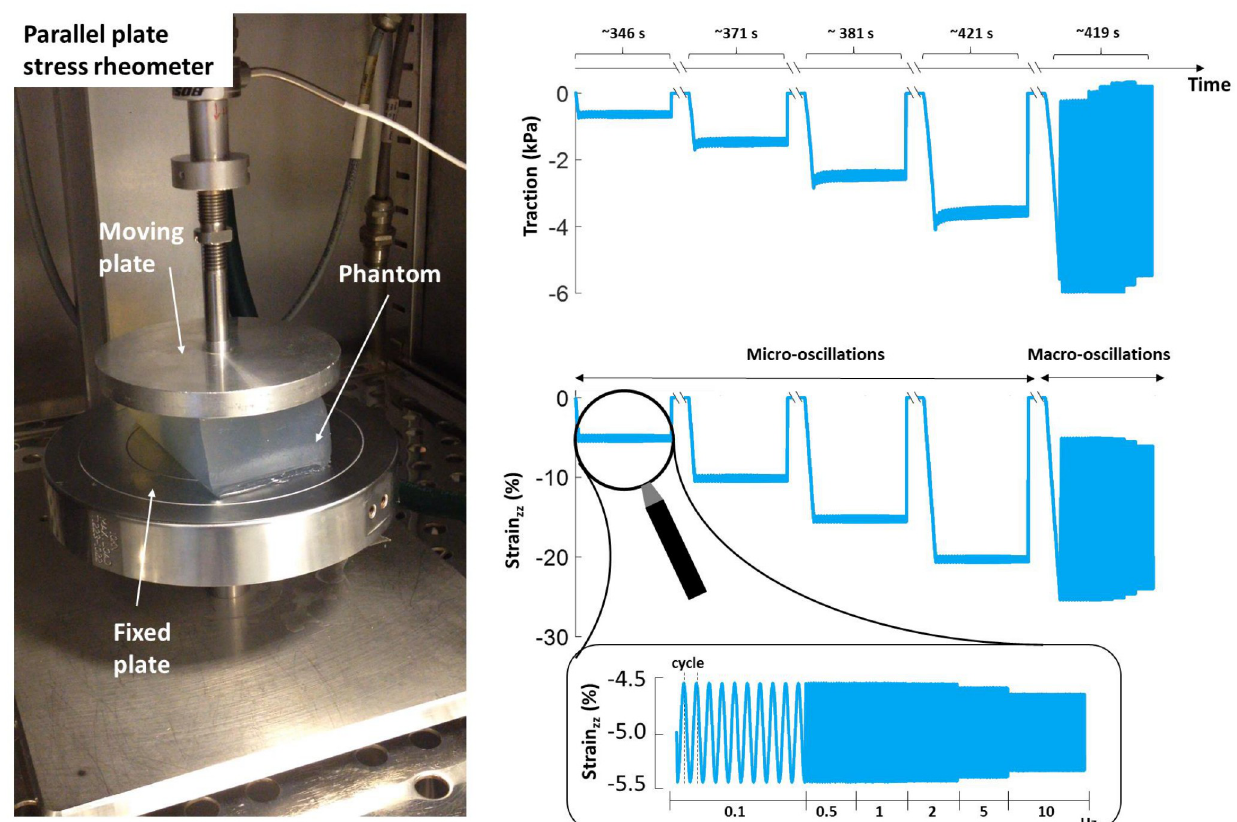
Fig 1. Viscoelastic characterisation of plastisol material. The experimental setup used for the viscoelastic characterisation of the phantom material (left). The moving plate was used to apply a fixed vertical compression on the sample and the load was measured through an integrated sensor. For each compression level, the phantom was subjected to four consecutive micro-oscillations and one macro-oscillation test (right). Each of those tests consisted of a series of oscillatory compression cycles centred around the selected compression level at different frequencies, as presented in the zoomed panel. Figure produced after the model proposed in